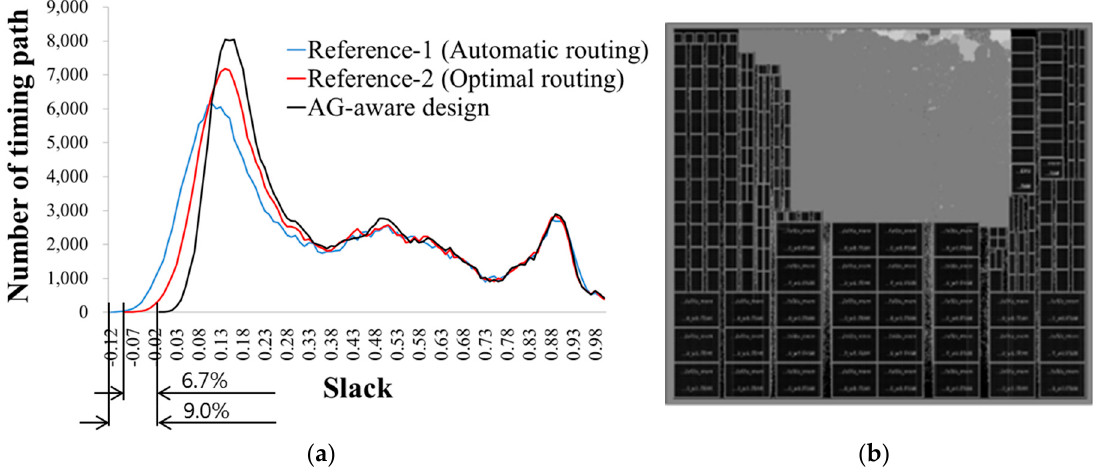
Figure 12. CPU10-A design: ( a ) slack distribution of the proposed AG-aware design and references and ( b ) chip layout.